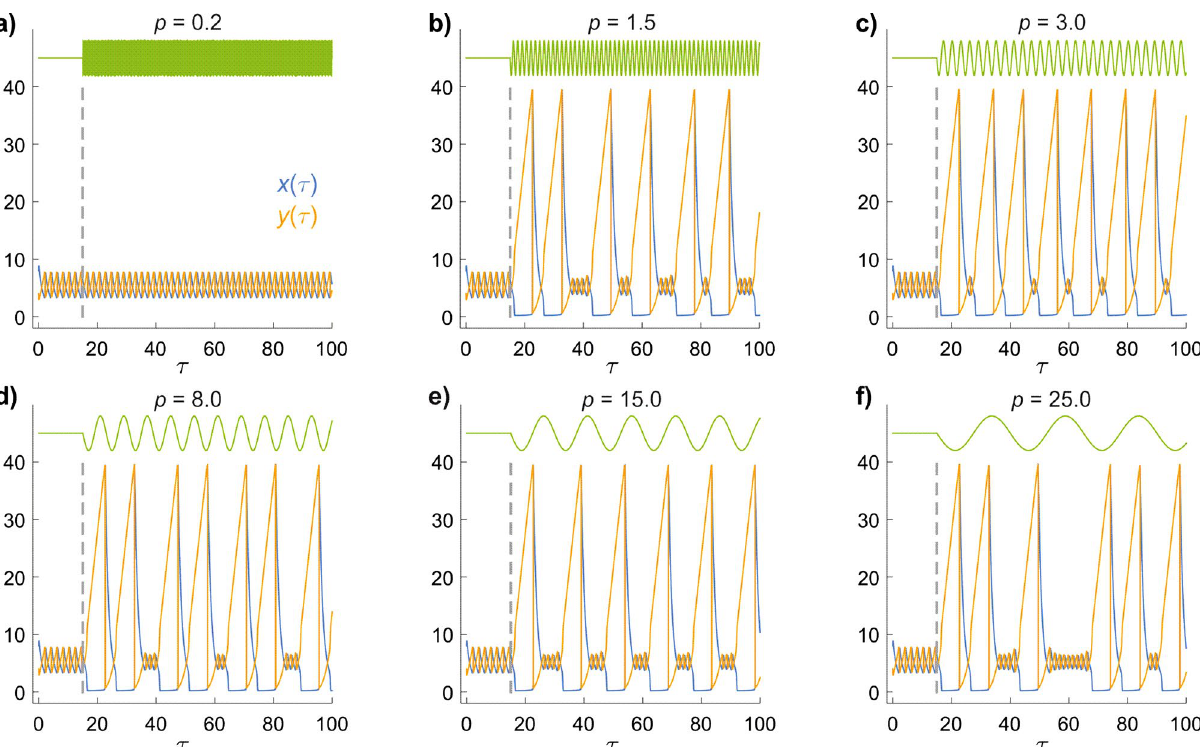
Figure 4. Time-dependence of the concentrations x (τ) and y (τ) when a is sinusoidally modulated at different frequencies. b = 26 for all six panels. The periods, p , of the oscillations are as indicated. The green lines at the top indicate the changes in a . The vertical dashed line at τ = 15 marks the time at which the modulation is switched